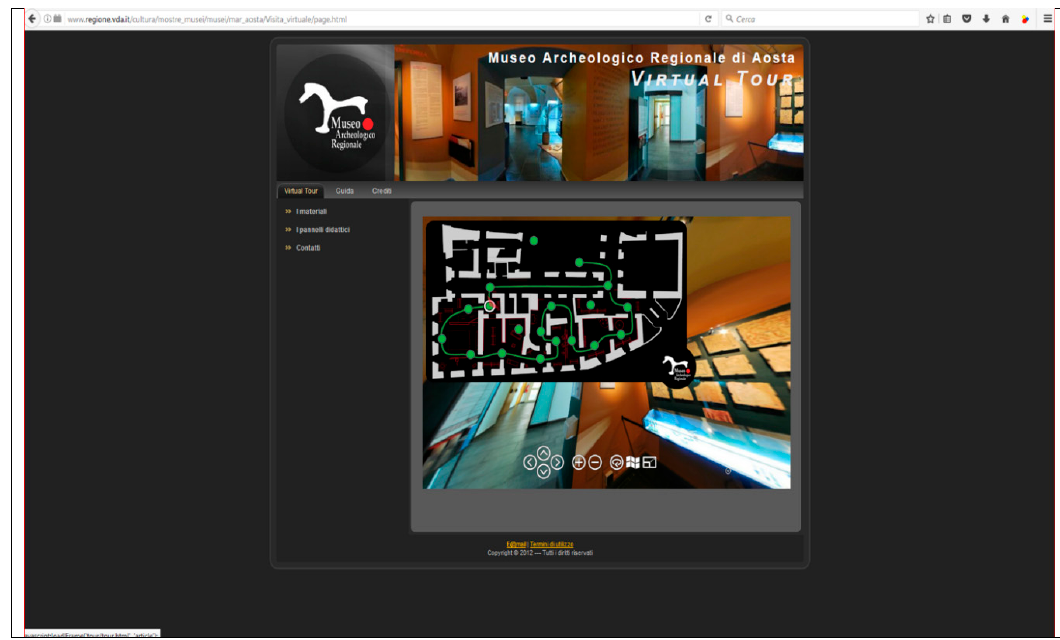
Figure A9: “Museo Archeologico Regionale (Aosta)”. Command bar, floor plan, 3D objects [31].